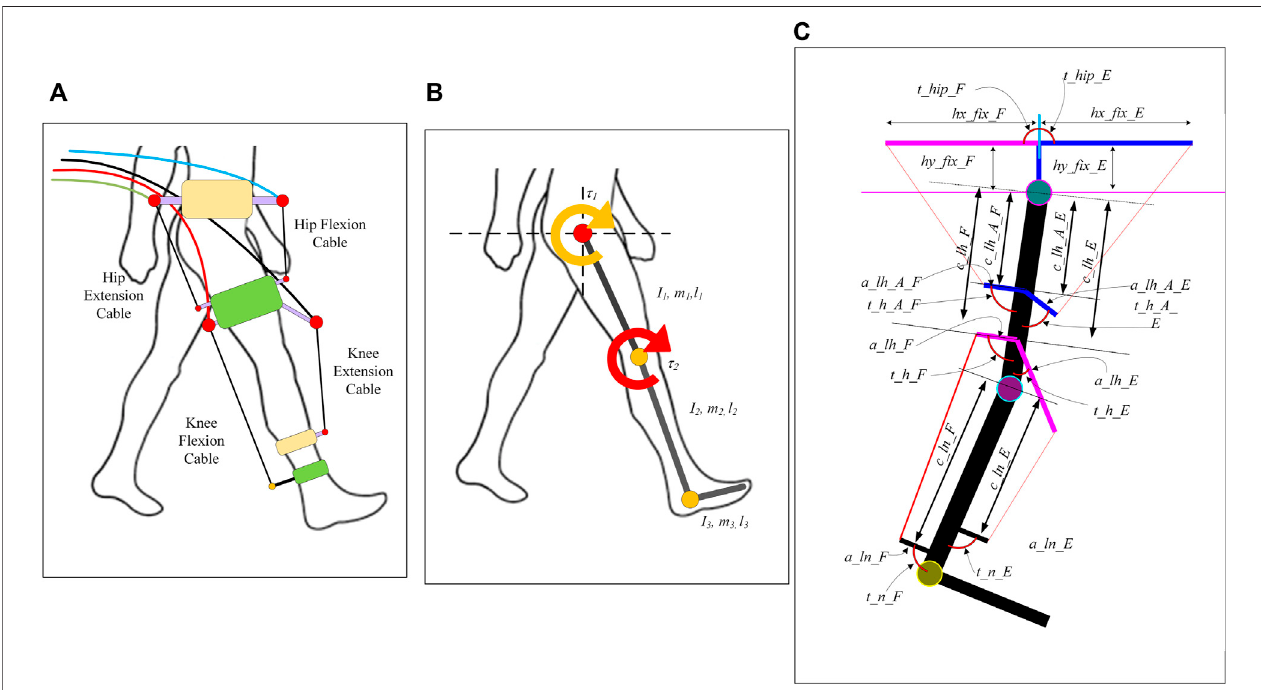
FIGURE 1 | Conceptual cable driven model (A) , 2 link-based model of lower limb (B) , and transformation of conceptual cable driven exoskeleton model into the link-based model (C) .